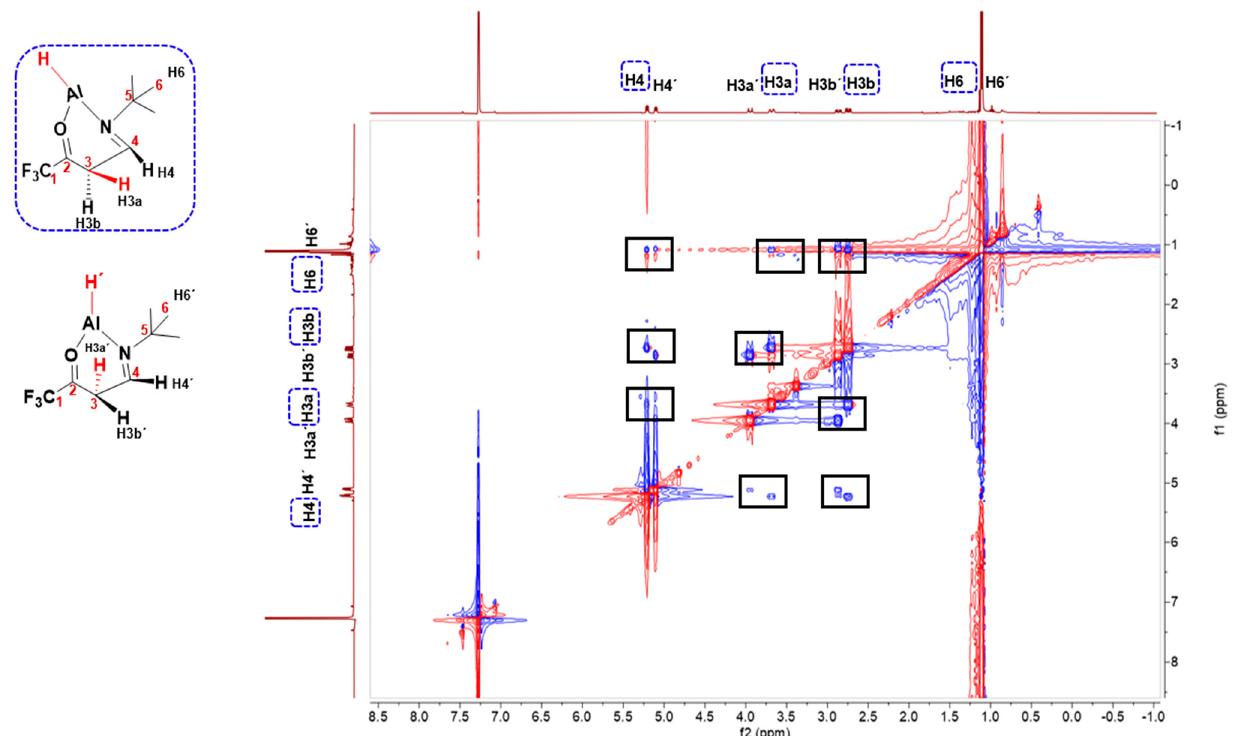
Figure 2. 1 H, 1 H NOESY spectrum ( δ in ppm) of 4b and 4b ′ measured in C6D6.